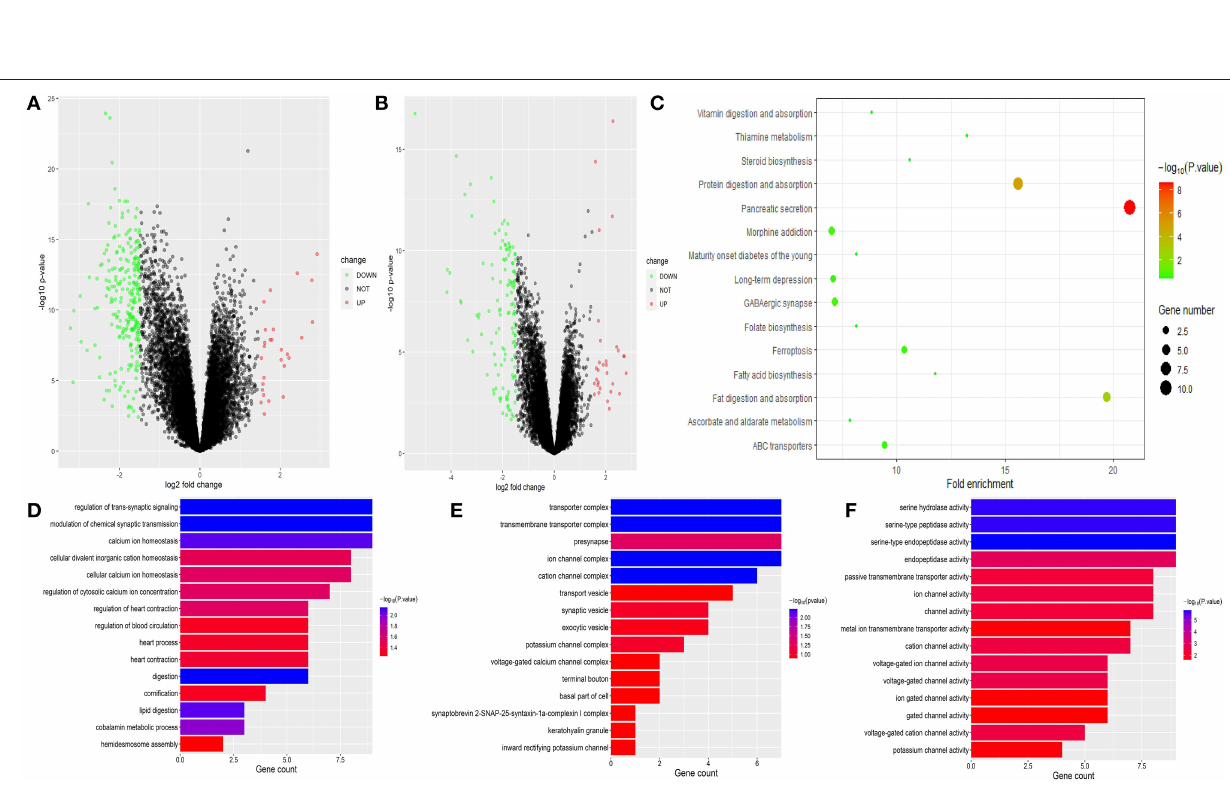
Frontiers in Cell and Developmental Biology |